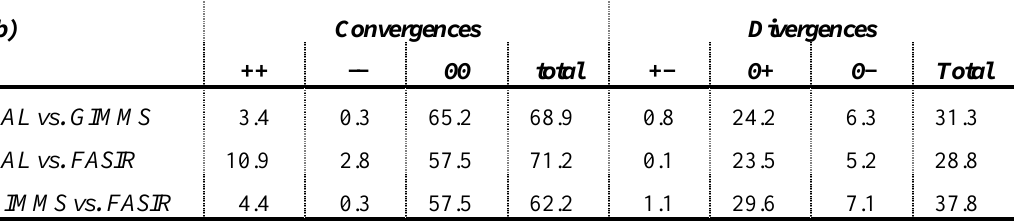
Figure 3. Trends of average annual NDVI, maximum annual NDVI, minimum annual NDVI and intra-annual coefficient of variation of NDVI in South America (H β≠ 0; p<0.1), for the FASIR, GIMMS and PAL series (1982-1999